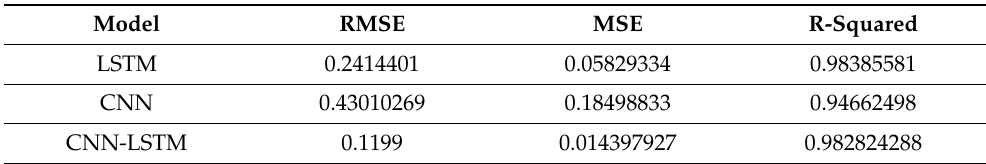
Table 3. Comparison of the performance metrics during the testing phase. Model RMSE